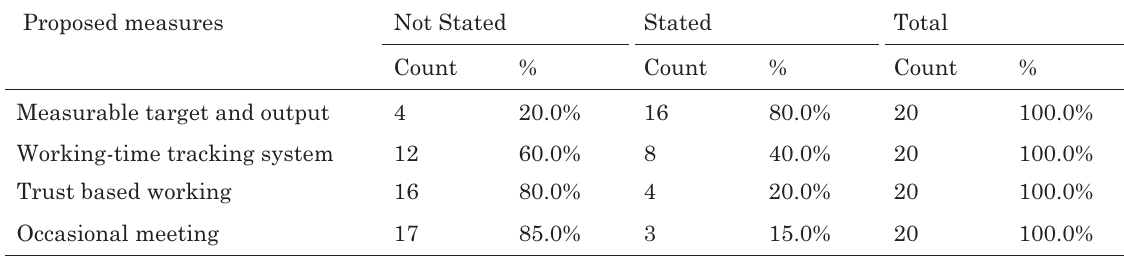
Table 2. Stated measures from Open-ended opinion Proposed